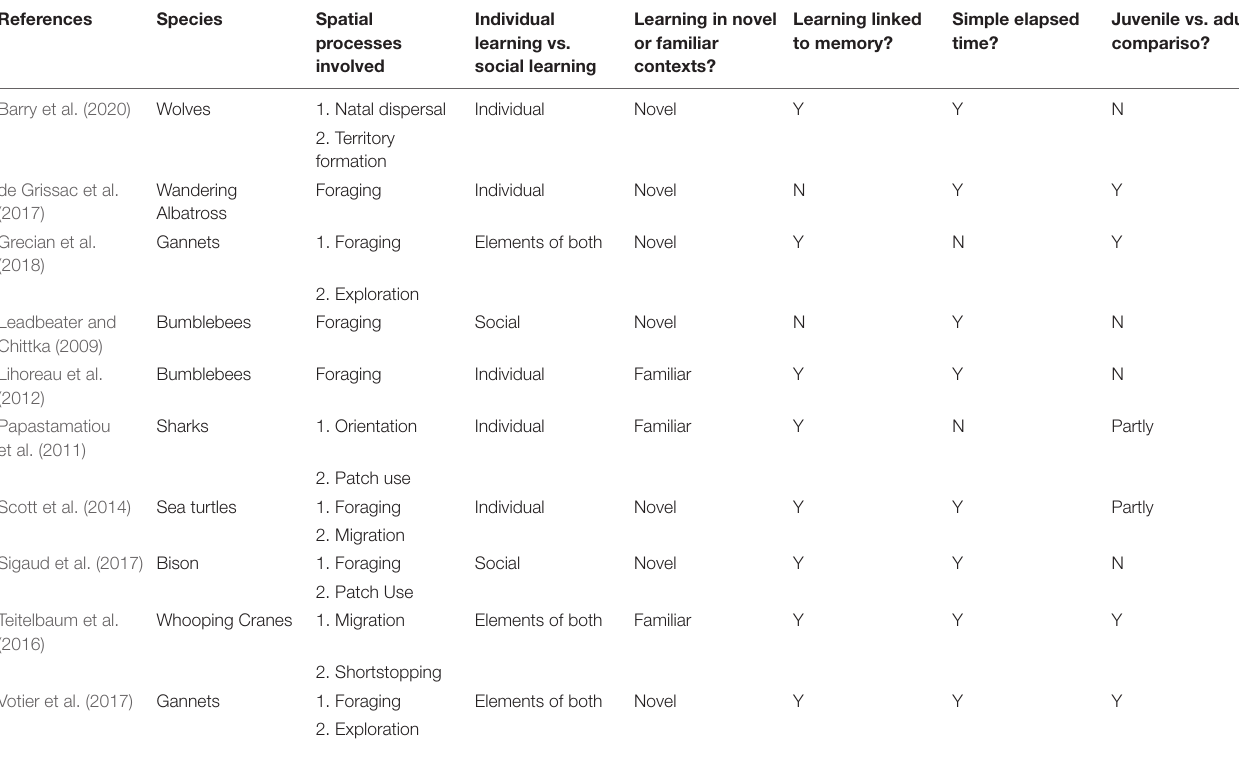
TABLE 1 | Case studies of learning and animal